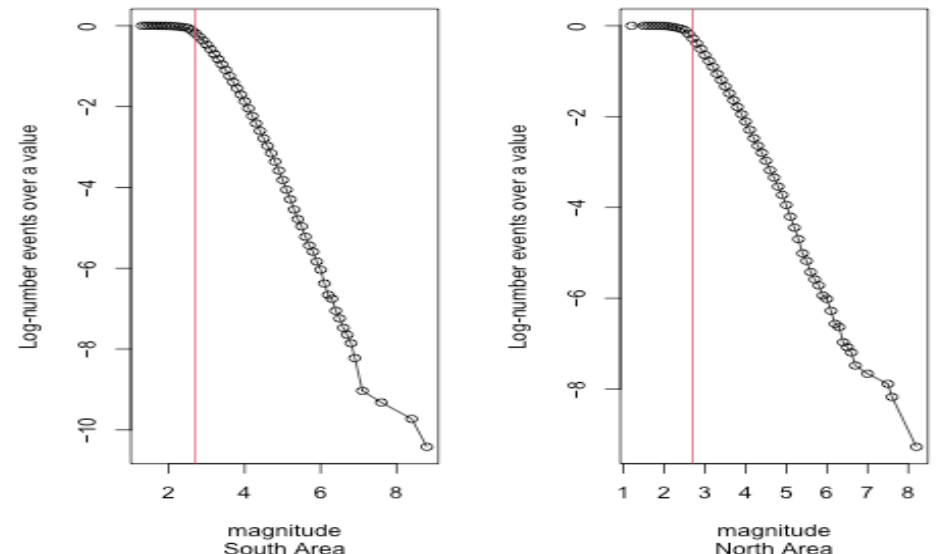
Figure 6. Log-cumulate distribution of magnitude in the Southern area (on the left ) and in the Northern area (on the right ).